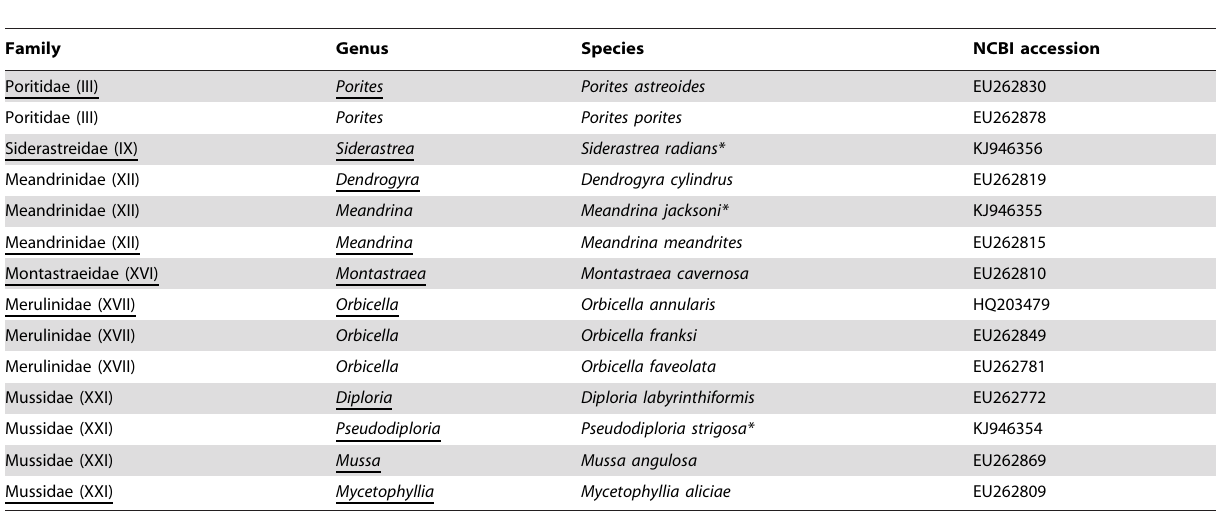
Table 1. List of scleractinian coral species used to measure constitutive immunity and its variation across taxonomic